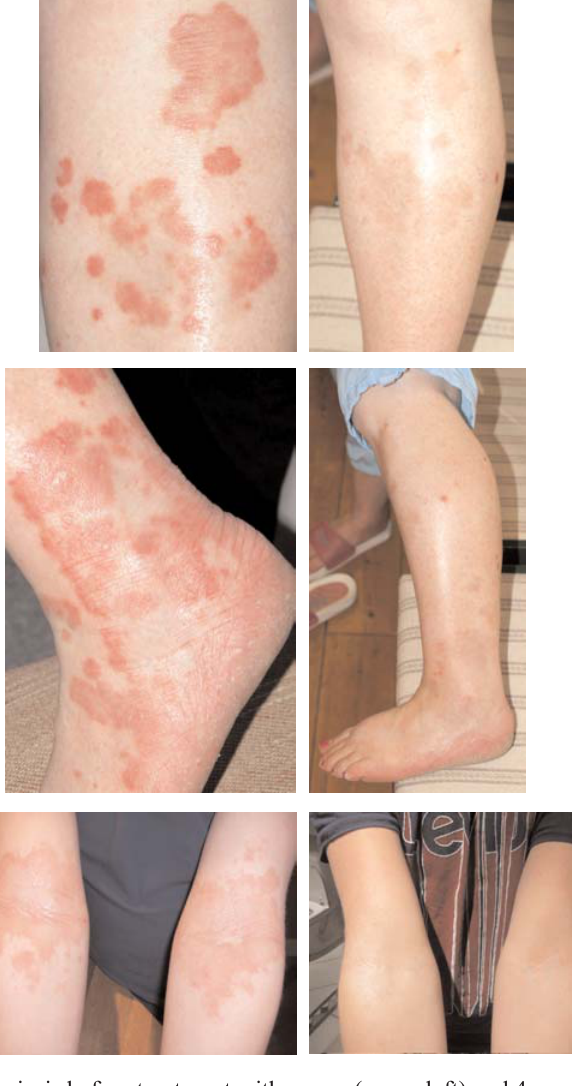
Figure 4 : Patient with psoriasis before treatment with cream (upper left) and 4 months after treatment with cream (upper right). Another patient with psoriasis before treatment with cream (middle left) and 4 months after treat- ment with cream (middle right). Patient with atopic dermatitis before treatment with cream (lower left) and 4 days after treatment with cream (lower